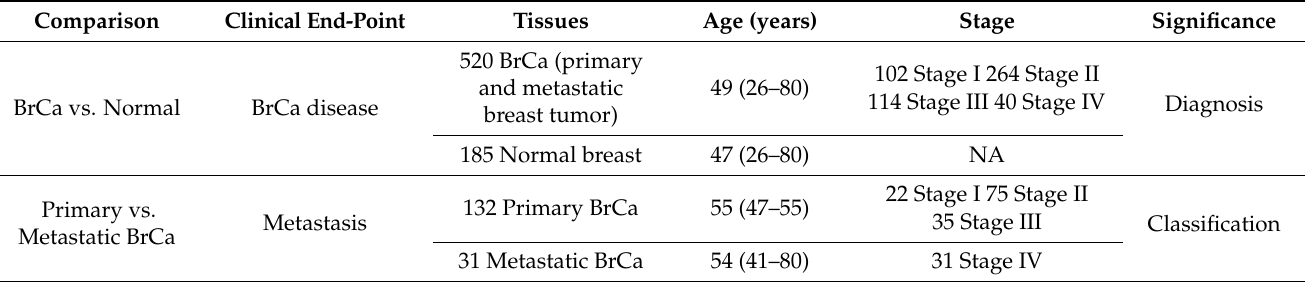
Table 3. Comparisons, end-points, study group characteristics and clinical significance of the datasets used in the bioinfor- matic